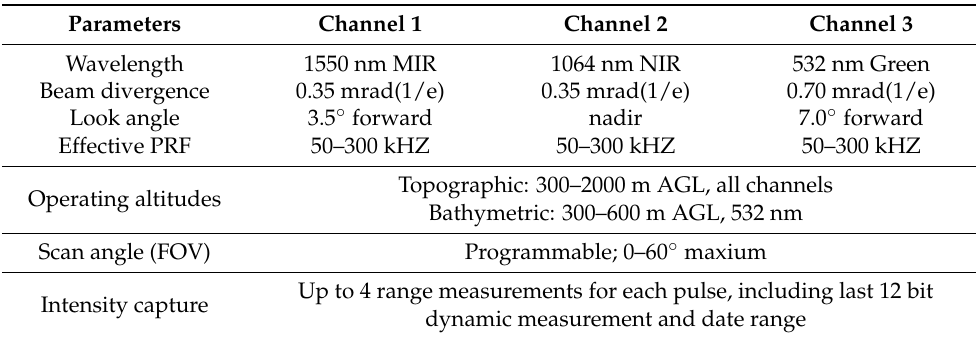
Table 1. Optech Titan performance specifications.